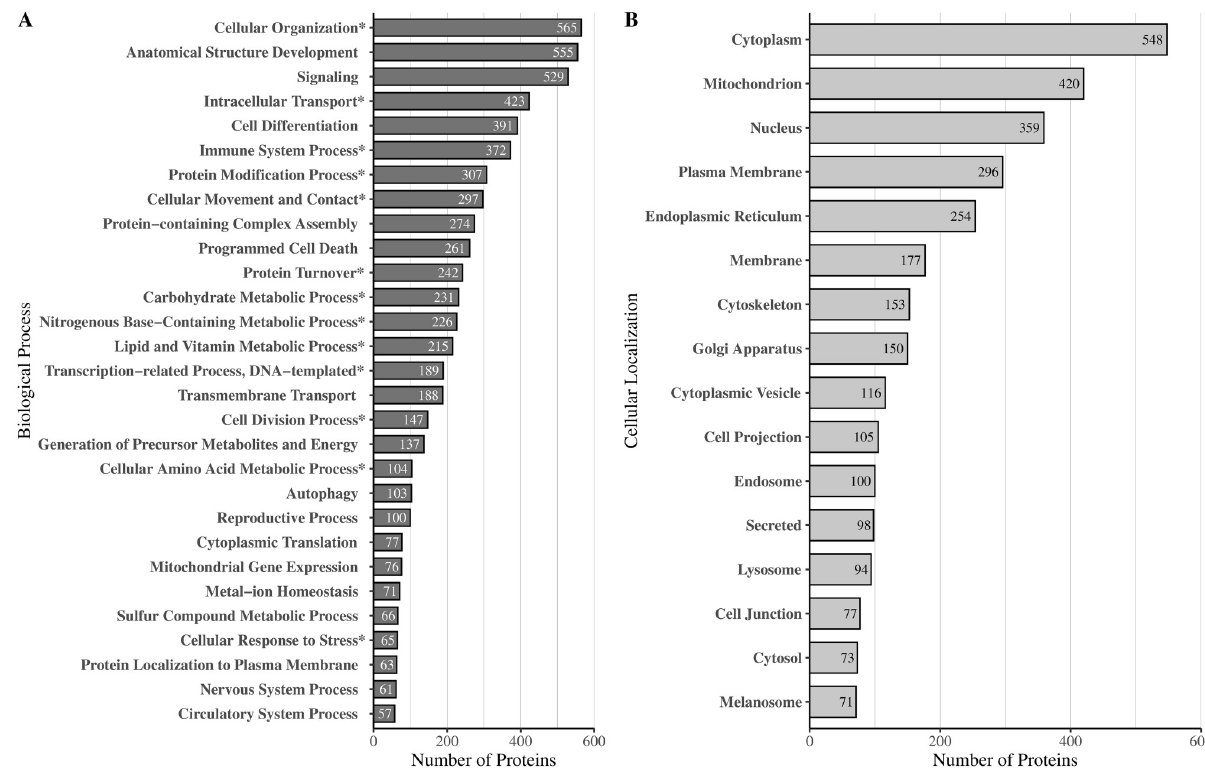
Fig 3. Gene ontology analysis of autophagosome-associated proteins from Leishmania -infected dTHP-1 cells. Proteins are categorized according to A) Biological Processes or B) Cellular Localization. The bars represent the number of proteins associated with each gene ontology (GO) term. Starred ( * ) gene ontology terms represent categories that encompass two or more related GO terms. Proteins with an organelle membrane or sub-organelle structure localization were relabeled as the corresponding organelle. The combined categories are outlined in S1 Table.